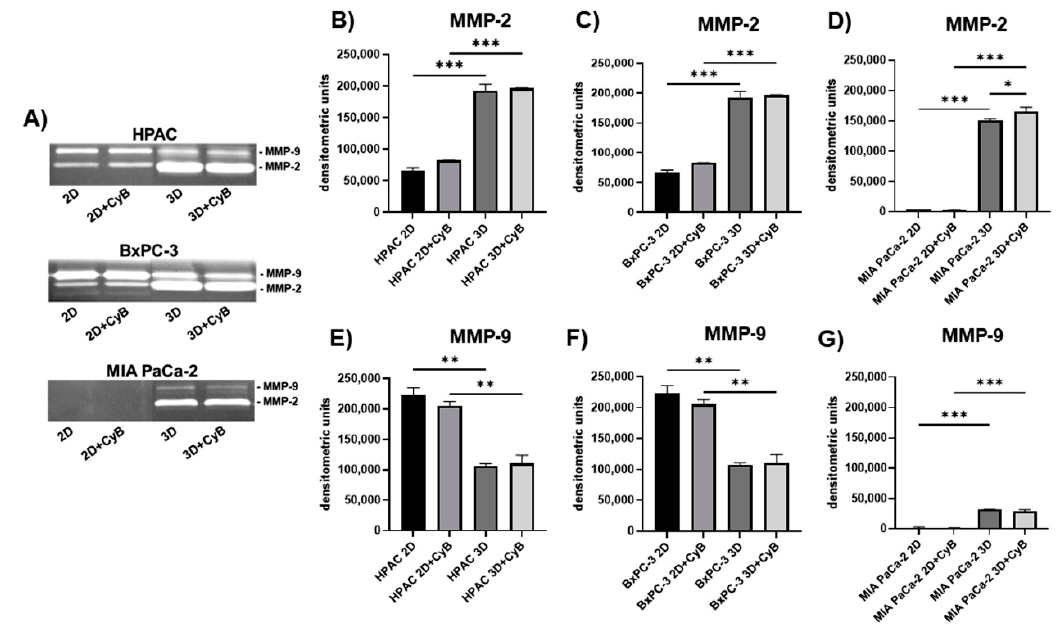
Figure 12. ( A ) Representative SDS-zymography showing MMP-2 and MMP-9 activity assayed in serum-free cell supernatants of PDAC cells. Bar graphs showing MMP-2 and MMP-9 activity after densitometric analysis of lytic bands, respectively, in HPAC ( B , E ), BxPC-3 ( C , F ) and MIA PaCa-2 cells ( D , G ). Data are expressed as means ± SD. * p < 0.05, ** p < 0.01, *** p < 0.001.